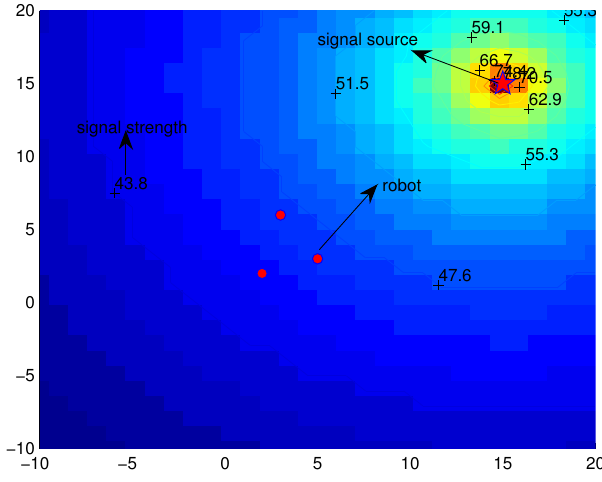
Figure 1. Search environment where the red point denotes the robot, and the red star is the signal source. The colors of the background represent the signal strength and are also labeled by the